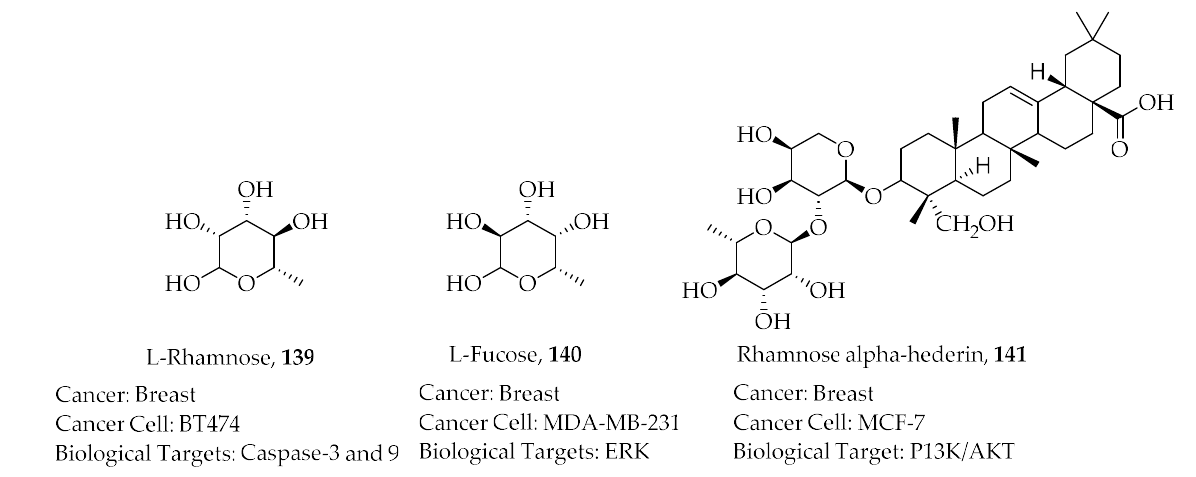
Figure 30. Structures of deoxy sugars L-Rhamnose, L-Fucose, and rhamnose β-hederin with a summary of their biological activity towards selected cancer targets.